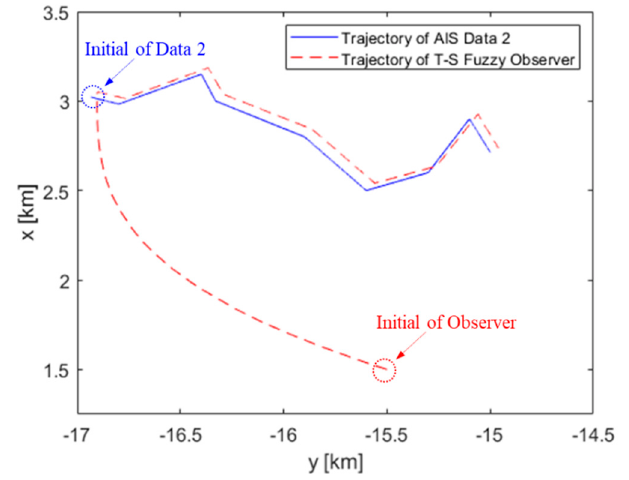
Figure 16. Observed results of AIS data 2.